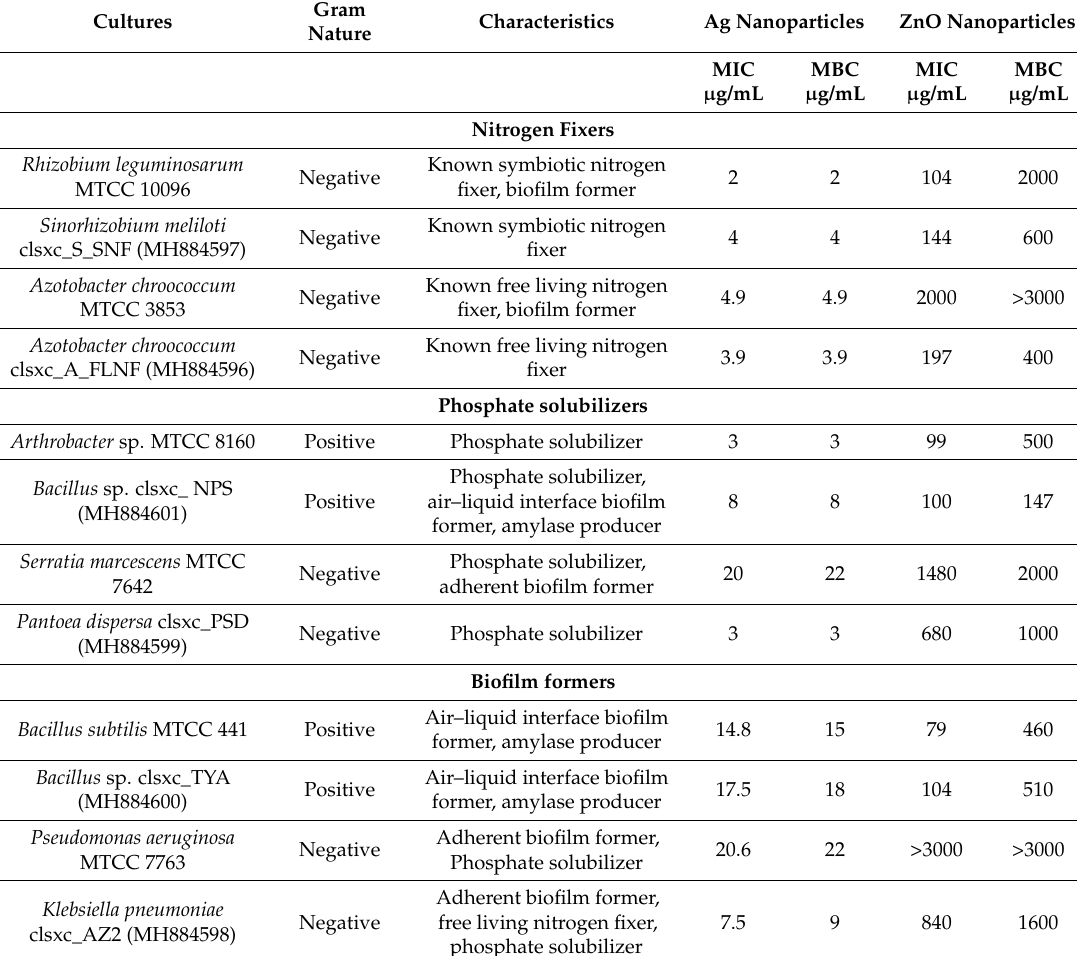
Table 1. Bacterial isolates and the MIC/MBC of Ag and ZnO nanoparticles for the isolates. The MIC and MBC values are average of five replicates, and have been rounded to the nearest significant